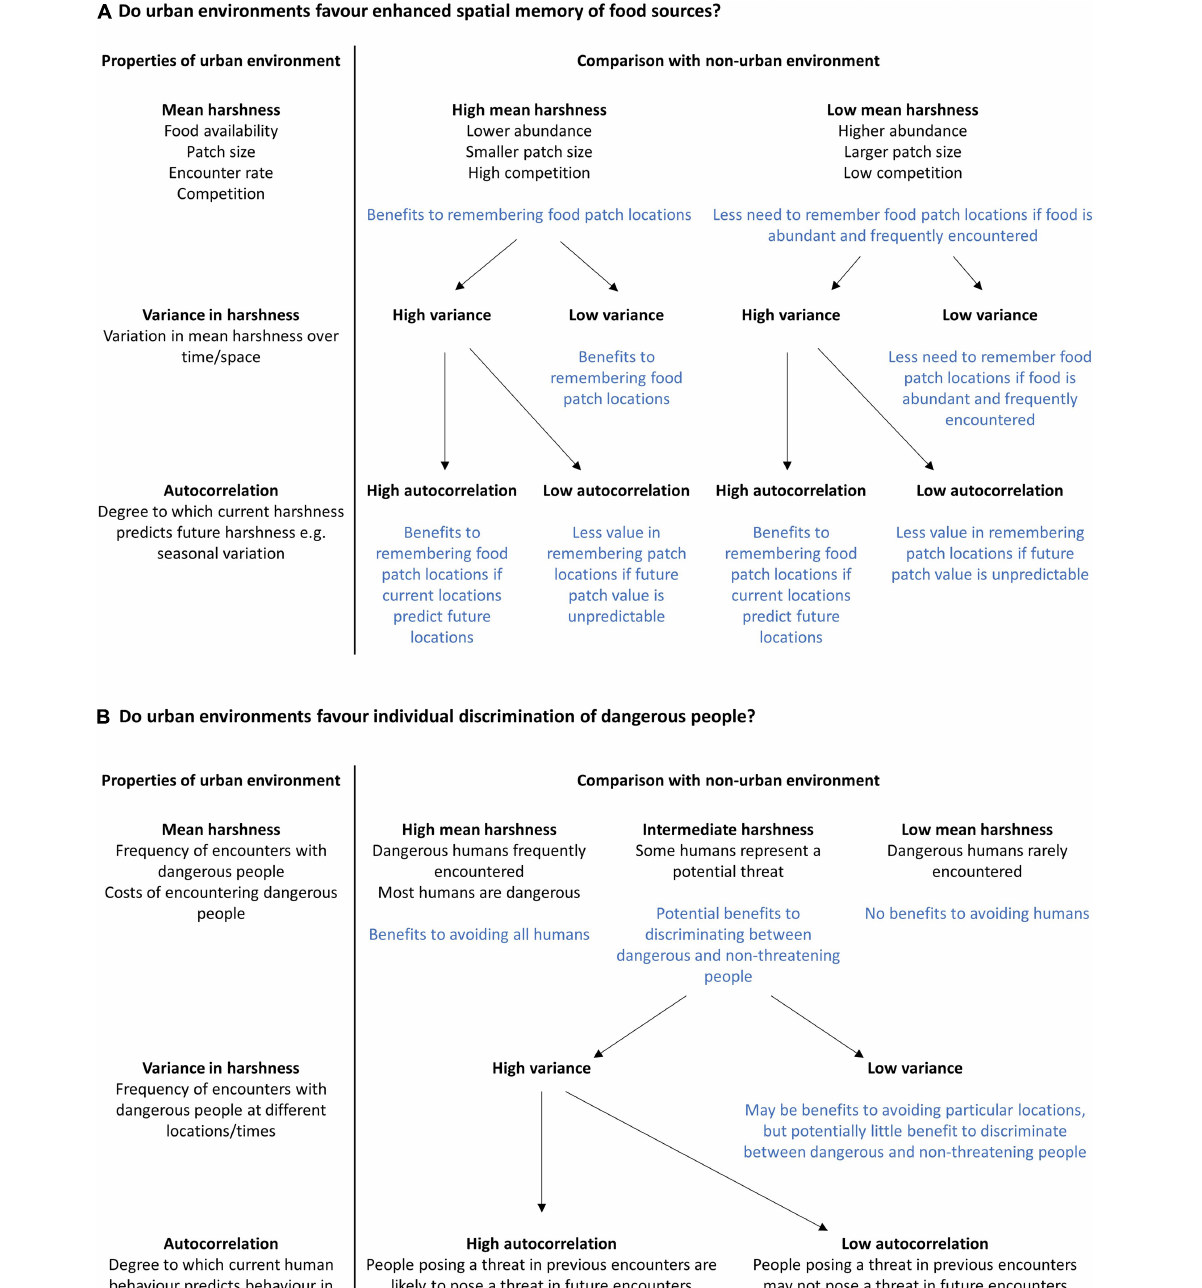
threats for urban animals, and how these differ from those available in non-urban habitats ( Figure 1 ). Determining the spatial and temporal distribution of fitness-relevant stimuli